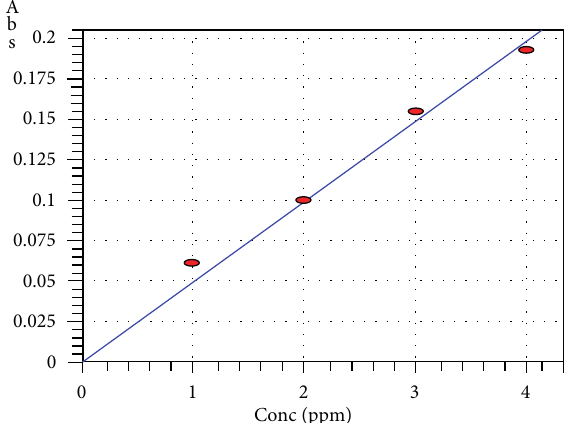
F 10: Calibration curve for Ni metal complexes for Atomic Absorption studies. e solutions of nickel complexes (10ppm),